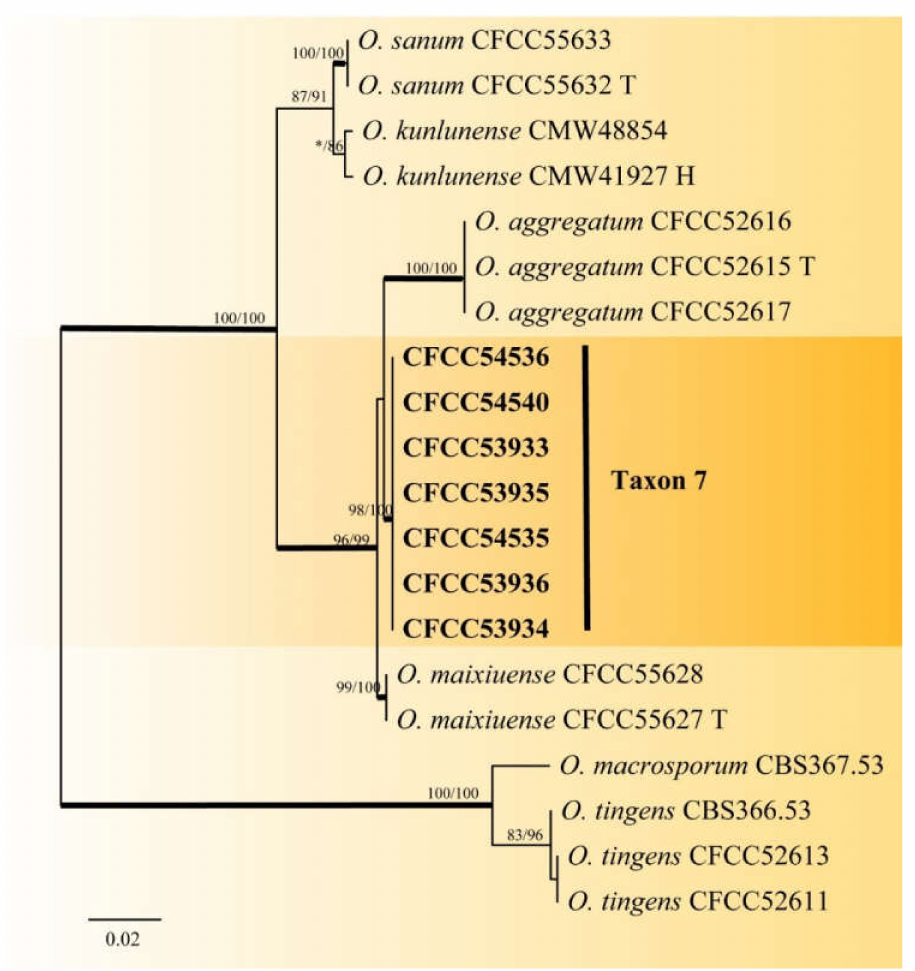
Figure 8. ML tree of Taxon 7 generated from the TUB2 sequence data. Novel sequences obtained in this study are presented in bold typeface. Bold branches indicate posterior probability values ≥ 0.9. Bootstrap values ≥ 70% for ML and MP are indicated above branches. Bootstrap values < 70% are indicated by *. Strains representing ex-type sequences are marked with